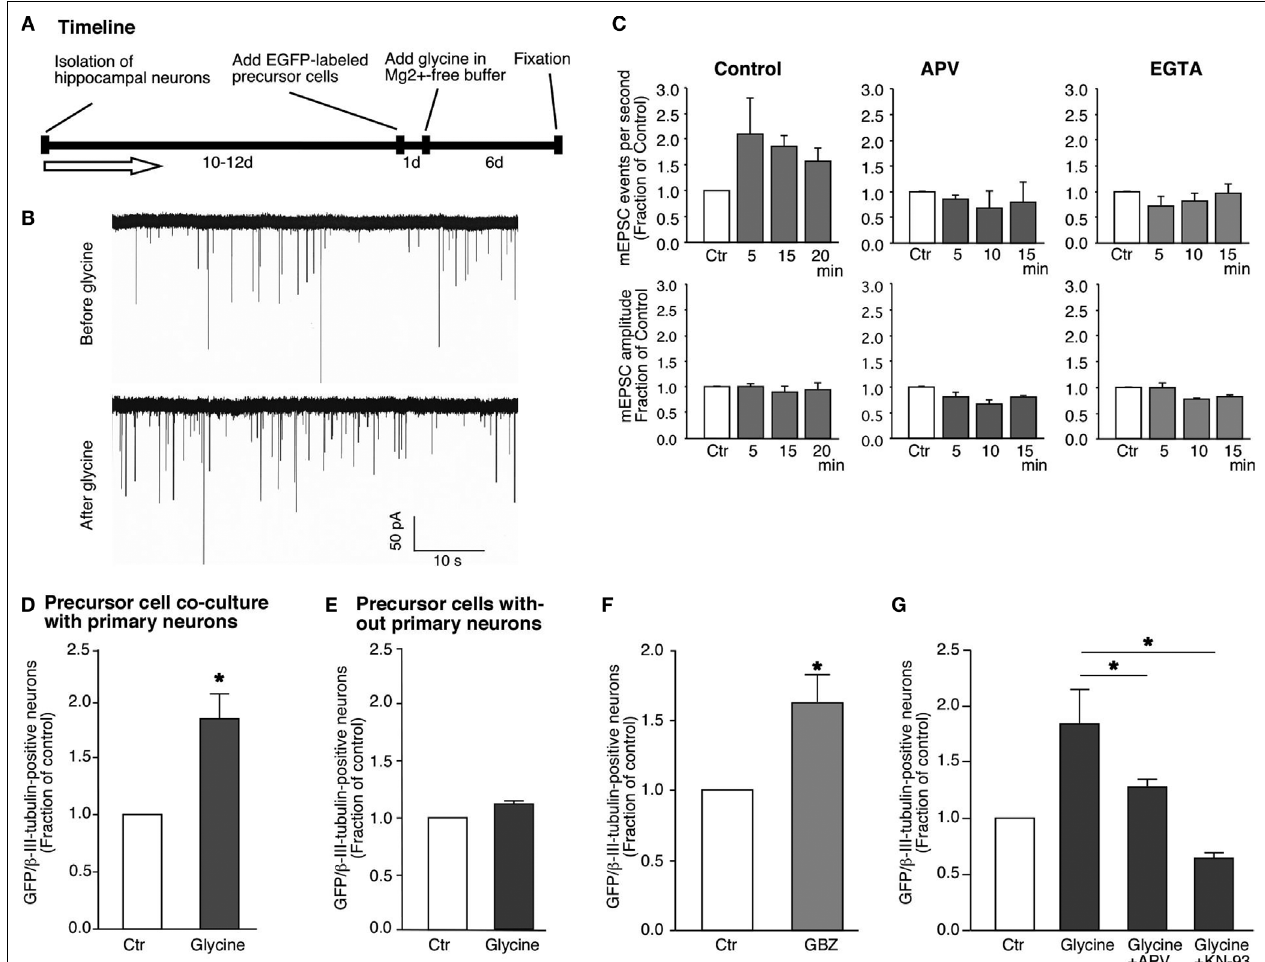
FIGURE 3 | Glycine-induced synaptic plasticity changes are associated with neuronal differentiation from neural precursor cells. (A) Experimental time line for glycine induced synaptic plasticity changes and associated neuronal differentiation. (B) Glycine induced an increase in the frequency of mEPSCs in hippocampal neurons [158 ± 24% ( n = 4) compared to the controls]. The recordings were performed before and after the addition of glycine. There was no change in the amplitude of the mEPSCs. The experiments were performed on neurons that were 12 days old. (C) This increase in the frequency of mEPSCs was blocked by the inhibition of NMDA receptors by APV and also by the chelating intracellular Ca 2 + with EGTA. (D,E) Glycine induced increased neuronal differentiation from GFP- labeled neural precursor cells in co-culture with primary hippocampal neurons (Ctr; 1.0, LTP; 1.79 ± 0.22, P < 0.01). The co-cultures were stimulated with Mg 2 + -free